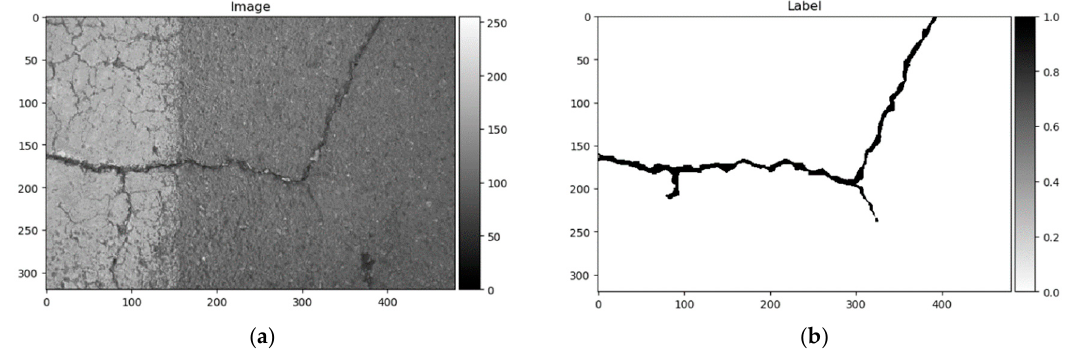
Figure 8. CrackForest data sample. ( a ) Image; ( b ) ground truth.